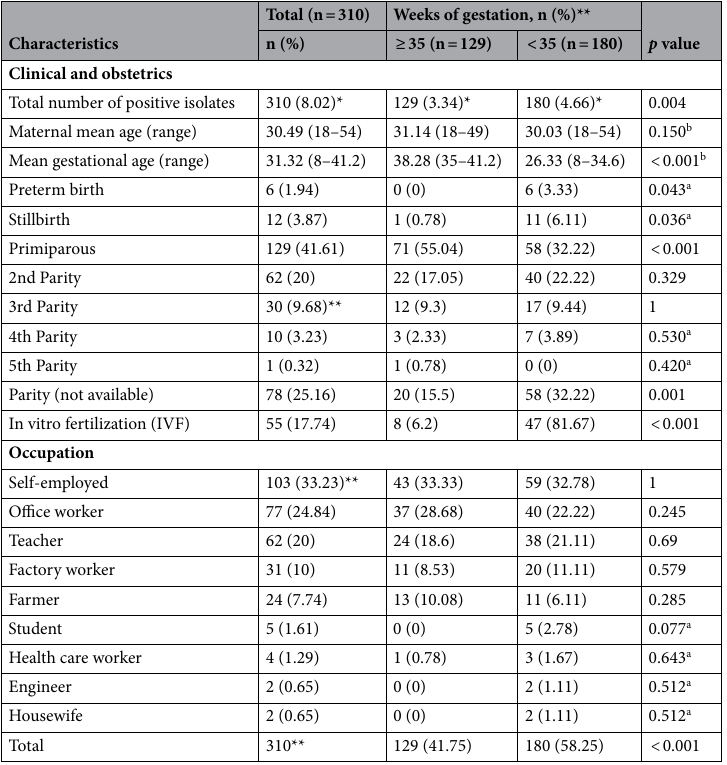
Table 1. The baseline characteristics of maternal GBS colonization. NS nonsignificant. *Calculated for the total study population (n = 3,863). **Gestational age was not available for one participant. a Fisher’s exact test. b Wilcoxon rank-sum